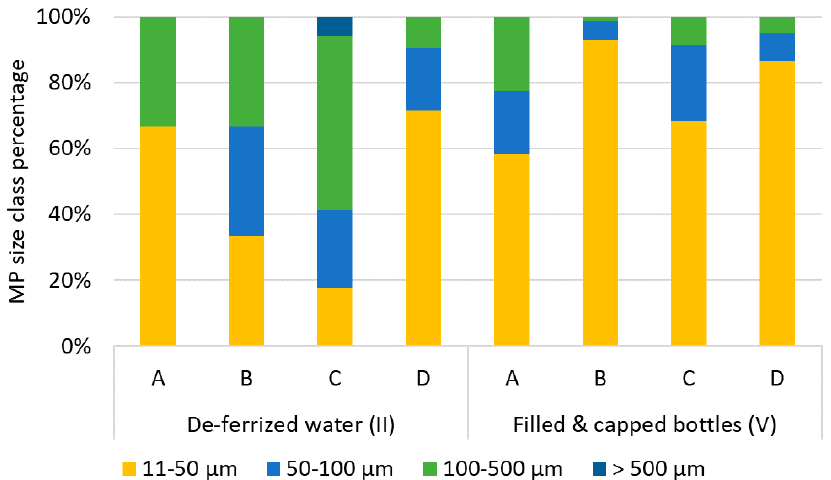
Figure 7. Percentage of MP per particle size class (particle length) in deferrized water (II) and filled and capped bottles (V) from bottlers